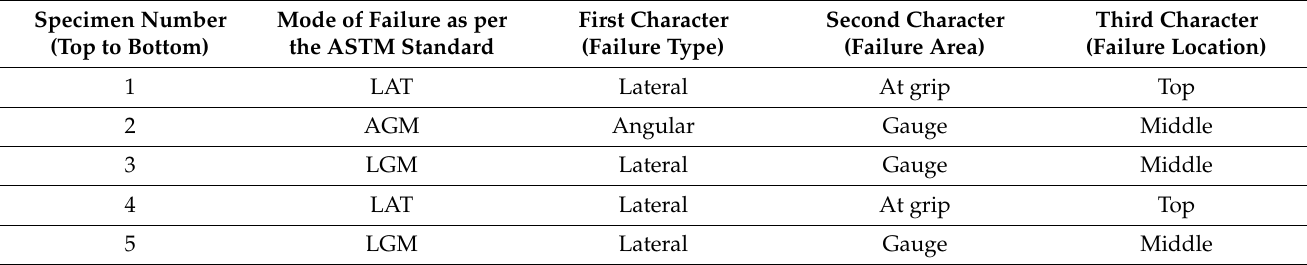
Table 4. Modes of failure—unfilled composite specimens.